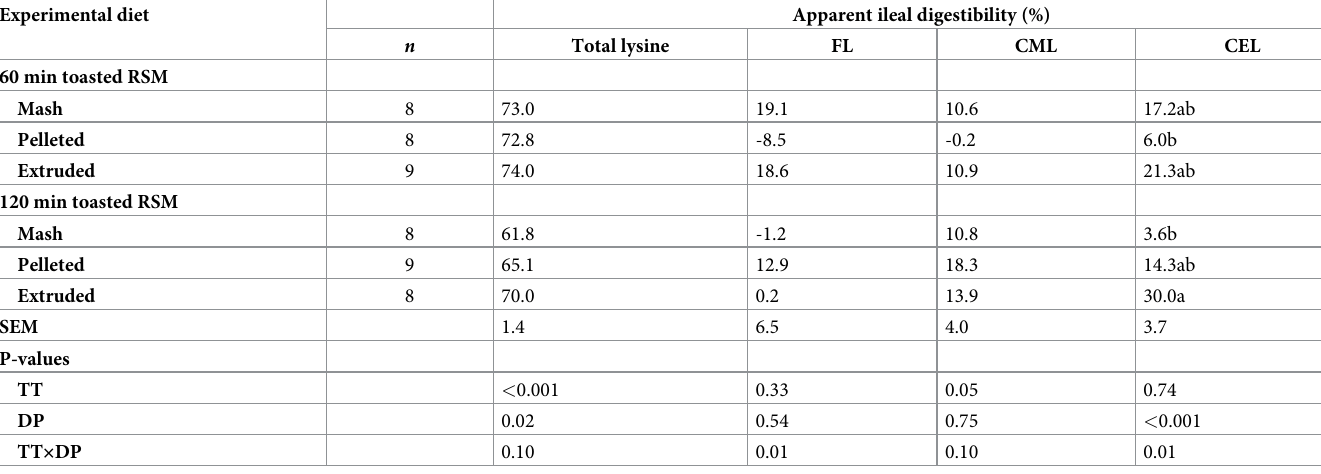
Table 4. Apparent ileal digestibility of total lysine, furosine, CML and CEL a, b . Experimental